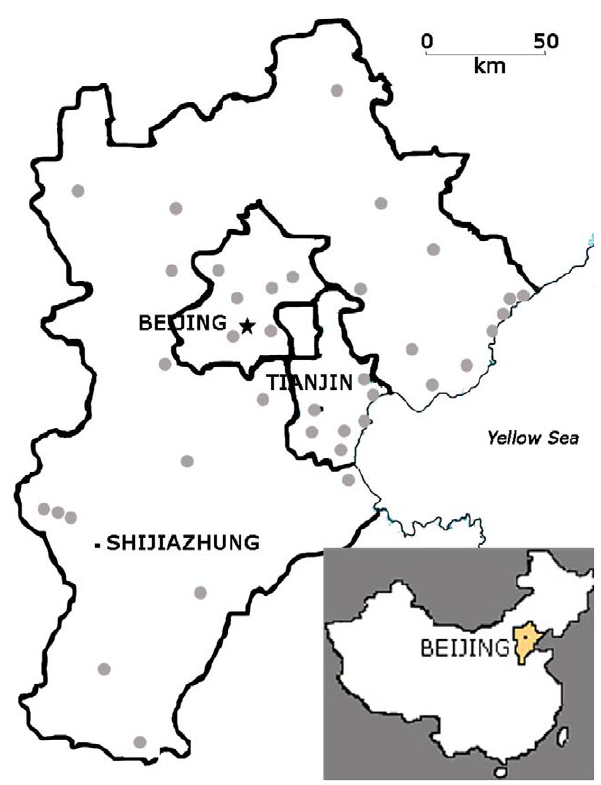
Figure 1. Map of the Greater Beijing Area. The Greater Beijing Area includes the Beijing and Tianjin Municipalities and Hebei Province. Grey spots indicate observation sites during the period 2004 2 2006.